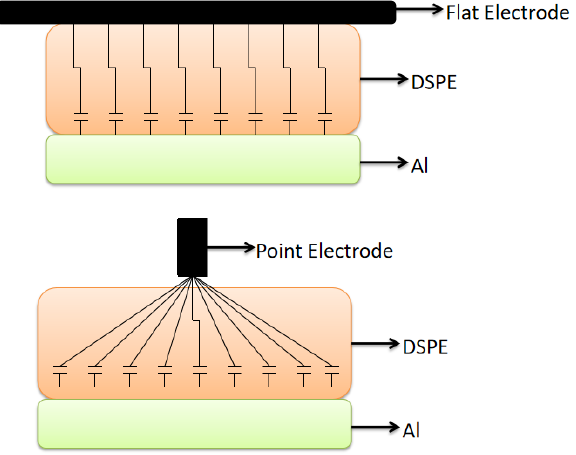
Figure 4. Equivalent parallel circuit schematic under plate and spot electrodes.